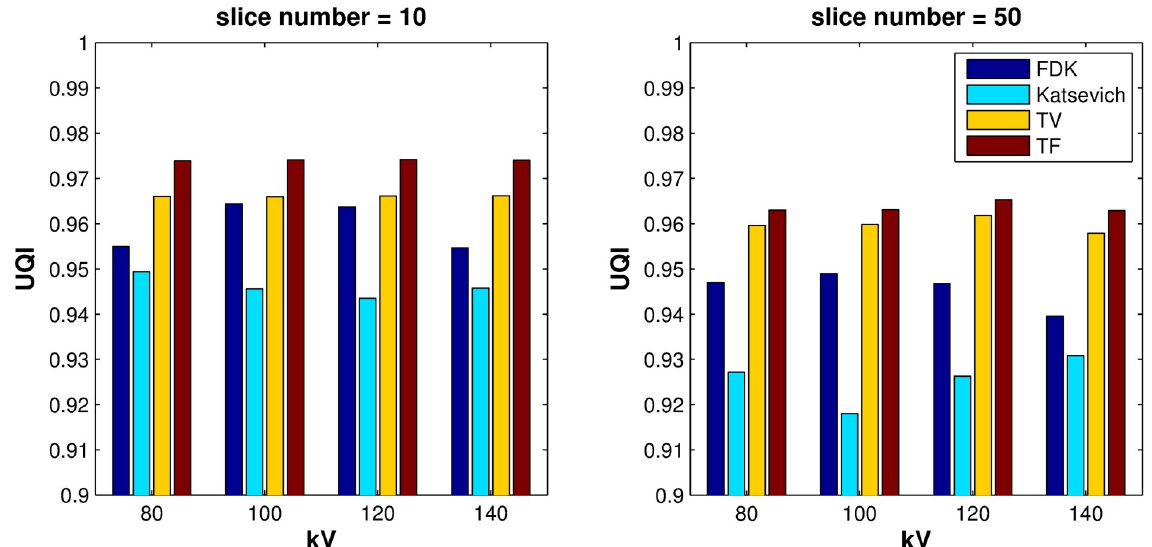
Fig 3. Image similarity measure: Bar plot of the UQIs of the different reconstruction algorithms over various dosage levels. (a): UQI on the 10-th slice, (b): UQI on the 50-th slice. https://doi.org/10.1371/journal.pone.0210410.g003 step 4, it is equivalent that both the rotation speed and the table movement are four times faster angles are shown in Figs 6 and 7. The images (a ) and (b ) are from the scanner on both fig- 0 0 ures. From the top to the bottom rows, images are reconstructed CT images by sampling steps 1, 4, 8, and 16. Each column shows images from a different reconstruction algorithm. From left to right, each column consists of images by scanner, FDK, Katsevich, TV and the TF